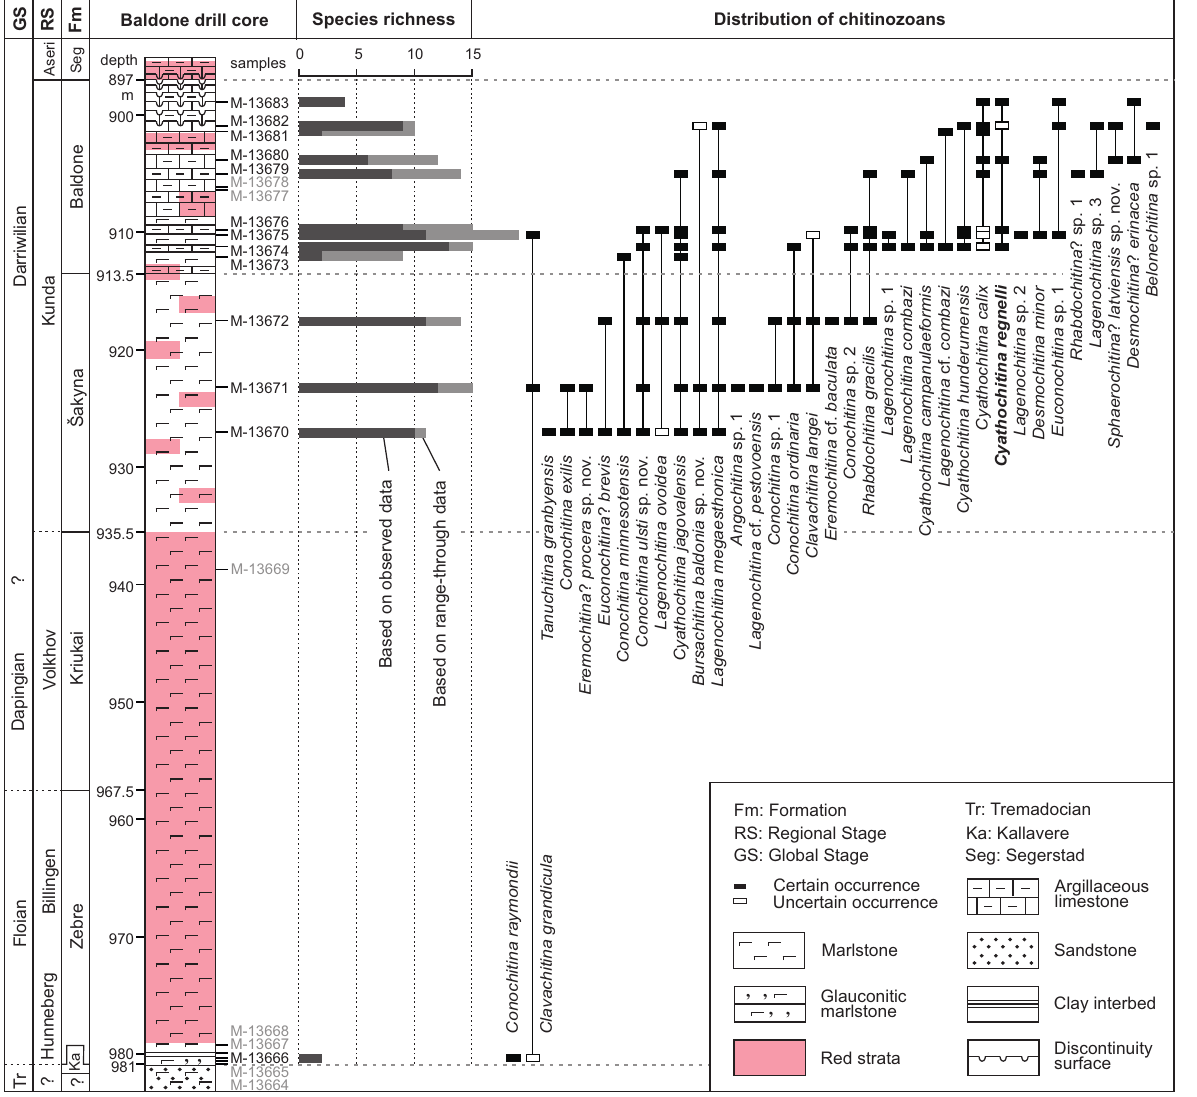
Fig. 2. Stratigraphic background and the distribution of chitinozoans in the Baldone drill core, central Latvia. Stratigraphy modified from Ulst et al. (1982). Grey sample numbers indicate barren